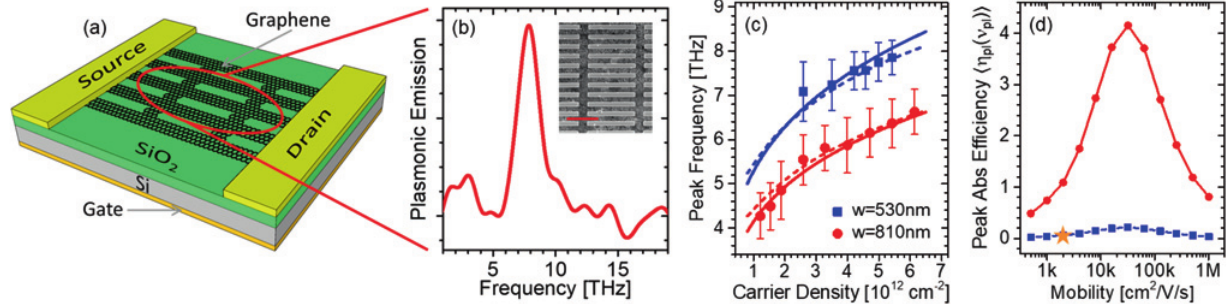
Figure 9: THz light emission from plasmonic oscillations in graphene nanoribbons. (a) Schematic device structure. (b) Measured radiation spectrum of a sample with 530 nm-wide ribbons and 1.0 μ m center-to-center spacing at a carrier density N = 5.4 × 10 12 cm − 2 , normalized to the spectrum at the charge neutrality point. The base temperature is 80 K and the input electrical power 0.2 W. Inset: top-view SEM image. The scale bar is 3 μ m. (c) Symbols: peak emission frequencies of the spectra measured with two devices of different nanoribbon width w. Solid lines: numerical fi ts to the analytical expression of Eq. (2) with a single fi tting parameter (the re fl ection phase φ r , for which a value of 0.27 π is estimated). Dashedlines:resonancefrequencies computedby FDTDsimulations. (d)Polarization-averagedpeak absorptionef fi ciencyversus mobility for two different plasmonic THz emitters. The blue squares correspond to the device of (b). The red circles correspond to the vertical- cavity nanoribbon device structure of Figure 6 (with 530 nm ribbon width and 4.4 μ m spacing) at N = 6.5 × 10 12 cm − 2 . In each structure, the nanoribbon fi llfactorisoptimizedformaximumabsorptionef fi ciency.Thestarsymbolindicatestheoperatingpointfortheexperimentaldata of (b). (a) – (c): reprinted with permission from ref. [115]. Copyright (2019), American Chemical